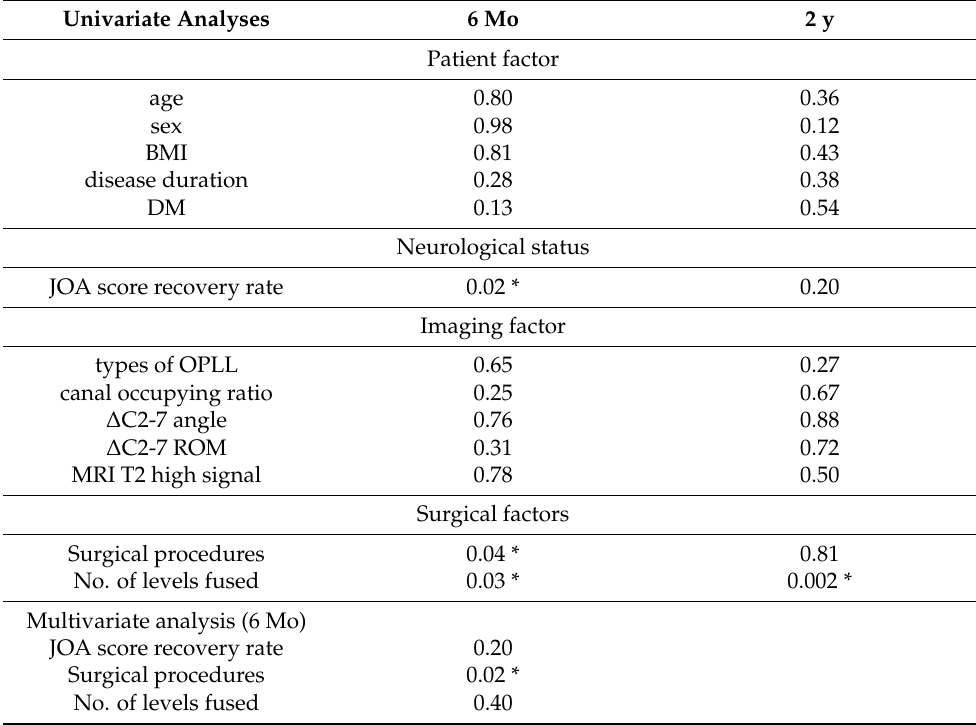
Table 3. Possible factors associated with postoperative neck pain